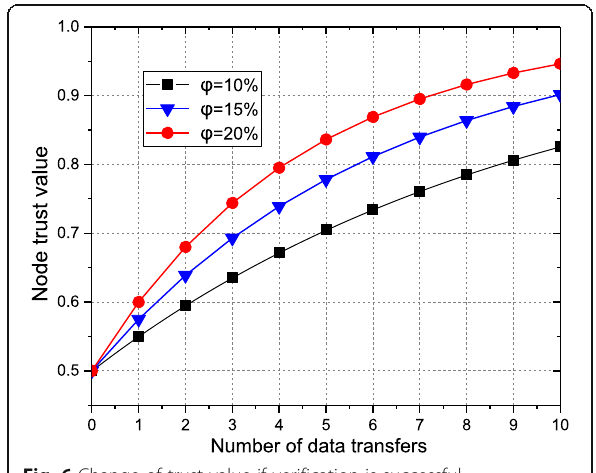
Fig. 7 Change of trust value if verification failed